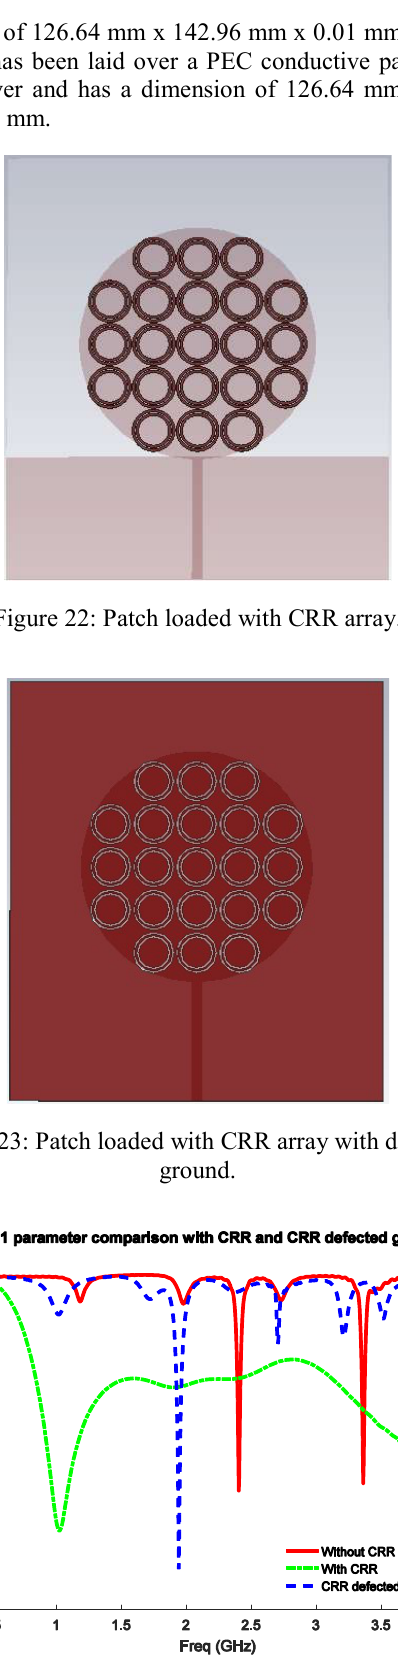
Figure 24: S11 parameter with and without CRR loading.